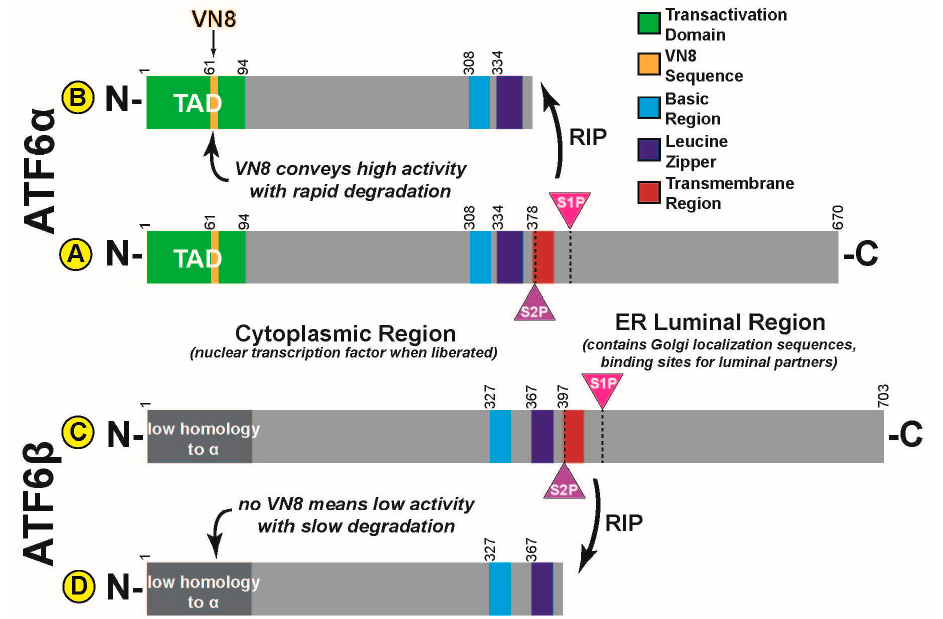
Figure 3. Structural comparison between ATF6 α and β . ( A ) Full length ATF6 α has an N-terminal cytosolic region with a transcriptional activation domain (TAD), a central basic leucine zipper domain (bZIP), and a transmembrane domain followed by a C-terminal luminal region; ( B ) The cytosolic region is liberated from the ER membrane by S1P and S2P Golgi proteases in a process called regulated intramembrane proteolysis (RIP). The TAD of the N-terminal fragment contains an eight-amino acid sequence, from amino acids 61 to 68, called the VN8, which confers high transcriptional activity and rapid degradation; ( C ) Full length ATF6 β has a similar structure to ATF6 α and its cytosolic region is also liberated from the ER membrane by S1P and S2P mediated RIP; ( D ) The N-terminal region of the soluble portion of ATF6 β has low homology to ATF6 α and, in particular, lacks the VN8 domain. N-ATF6 β is thus a weak transcriptional activator with a long half-life.